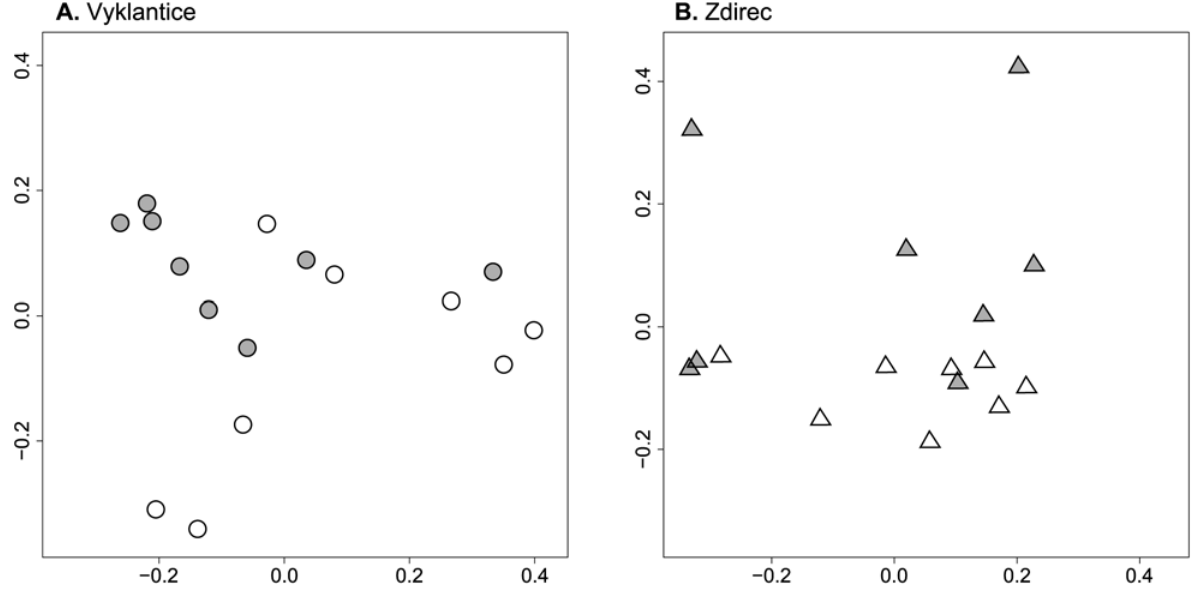
Figure 2. HPLC-UV profiles of extractable low-molecular-weight compounds at Vyklantice (A) and Zdirec (B) sites. Sammon ’ s multidimensional scaling was based on Manhattan distance matrices calculated from normalized signal at 210 nm (for details, see Materials and Methods). The symbols represent the profiles of compounds extracted from the fields with low (open symbols) and high (closed symbols) common scab severity.